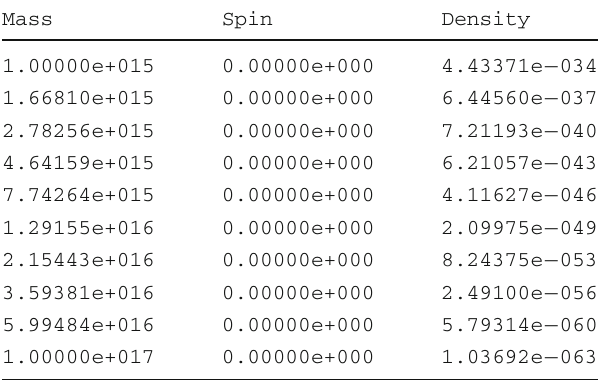
5 Initial BH comoving number density as a function of their